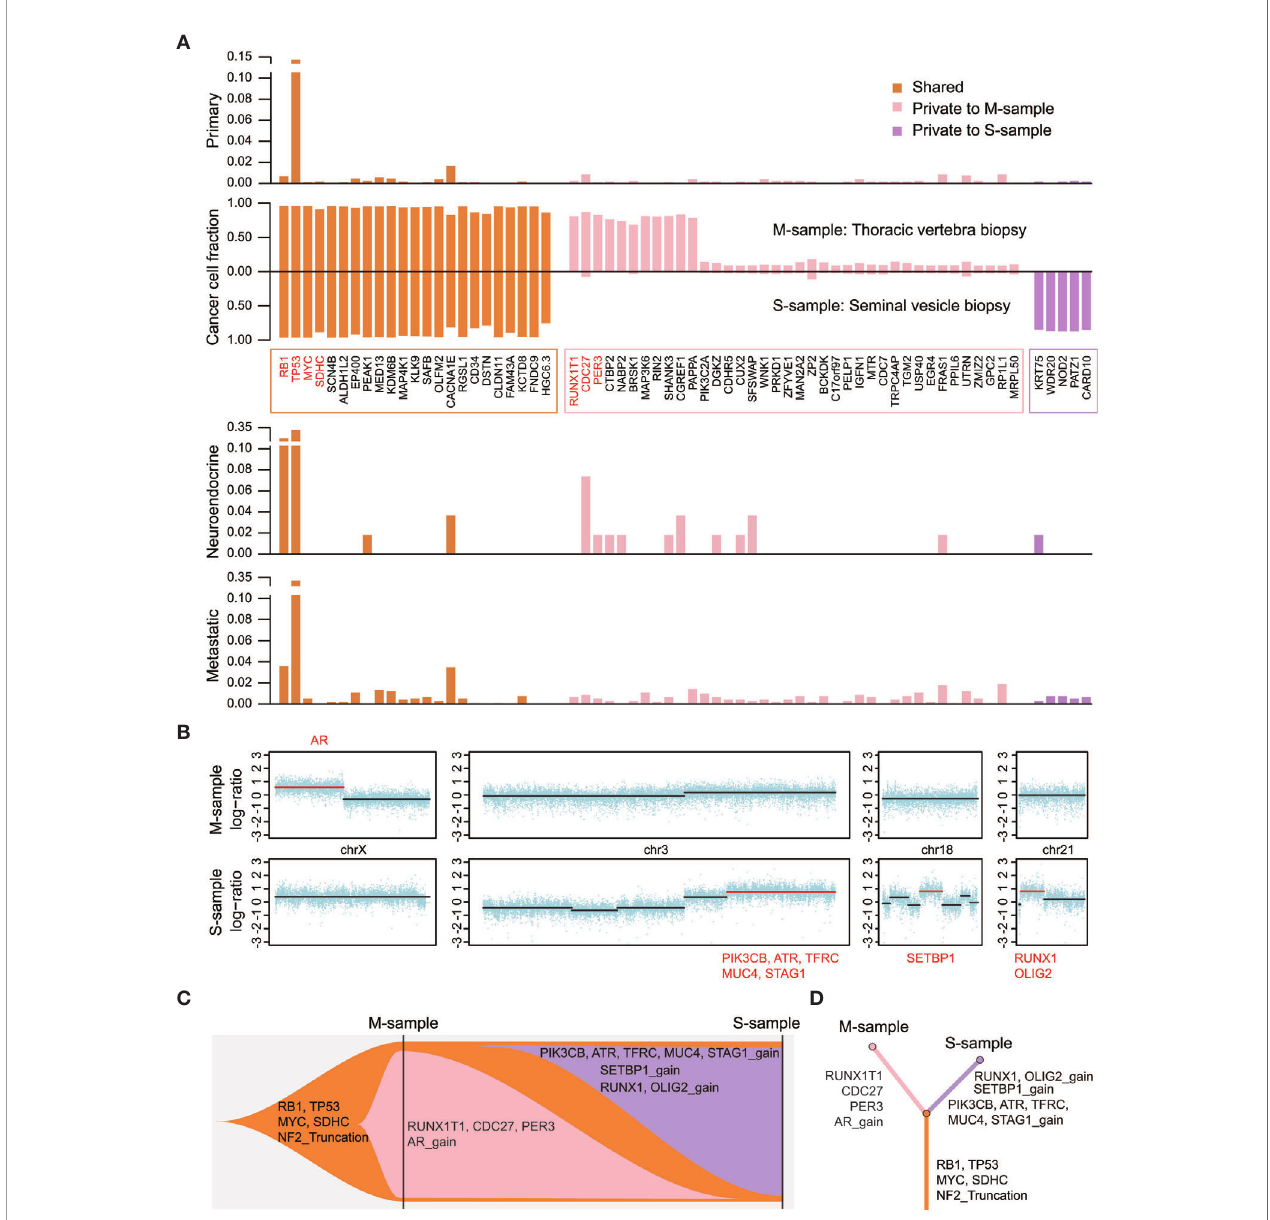
FIGURE 3 | The altered landscape and phylogenetic reconstruction of the two samples. (A) The second panel shows the cancer cell fraction estimated by using PyClone and calculated using the read depth of mutations, copy numbers, and purity of tumors. Other panels are showing the frequency of mutations in three types of prostate cancer using public data from the cBioPortal (1400 primary tumors, 54 NEPC samples, and 880 mCRPC samples). Important functional cancer genes are marked in red. (B) Overview of copy number alterations and cancer genes encompassed in segments are shown in red. (C, D) Fishplot indicating the dynamic clonal progression of the tumor, and clonal evolution tree showing the phylogenetic relationship between the two